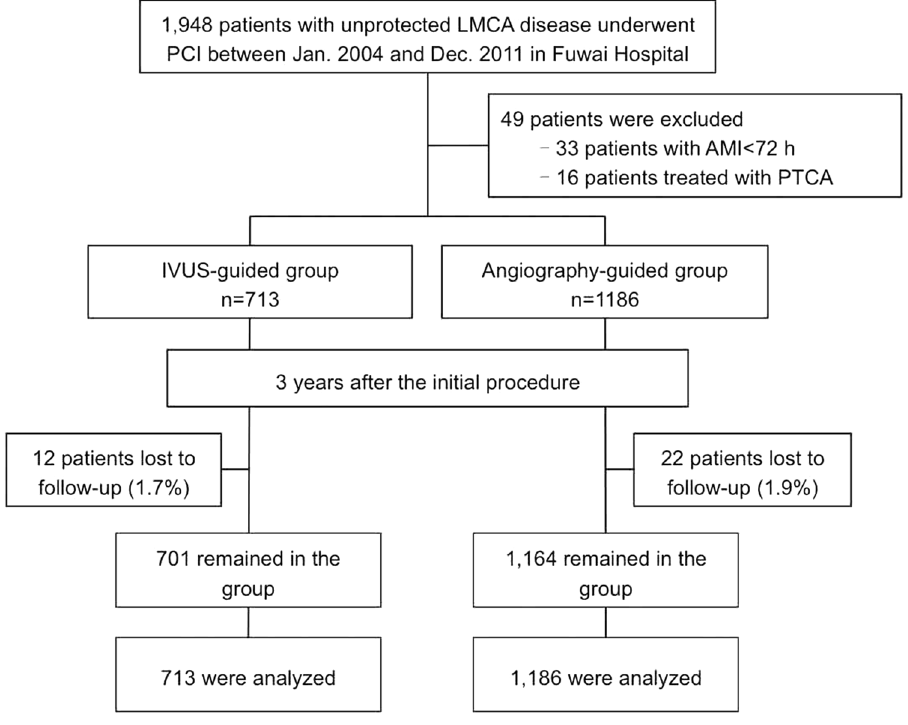
Figure 1. Patient Flowchart. AMI = acute myocardial infarction; IVUS = intravascular ultrasound; LMCA = left main coronary artery; PCI = percutaneous coronary intervention; PTCA = percutaneous transluminal coronary